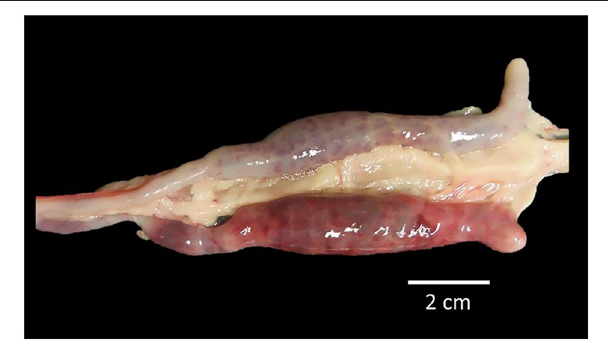
FIGURE 6 | Severe lesions in both ceca sacs of SPF White Leghorn chick infected with a high dose of sporulated oocysts of E. tenella and treated by